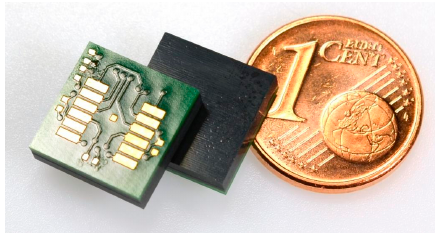
Figure 7. Separated inertia sensor-FlexPac.